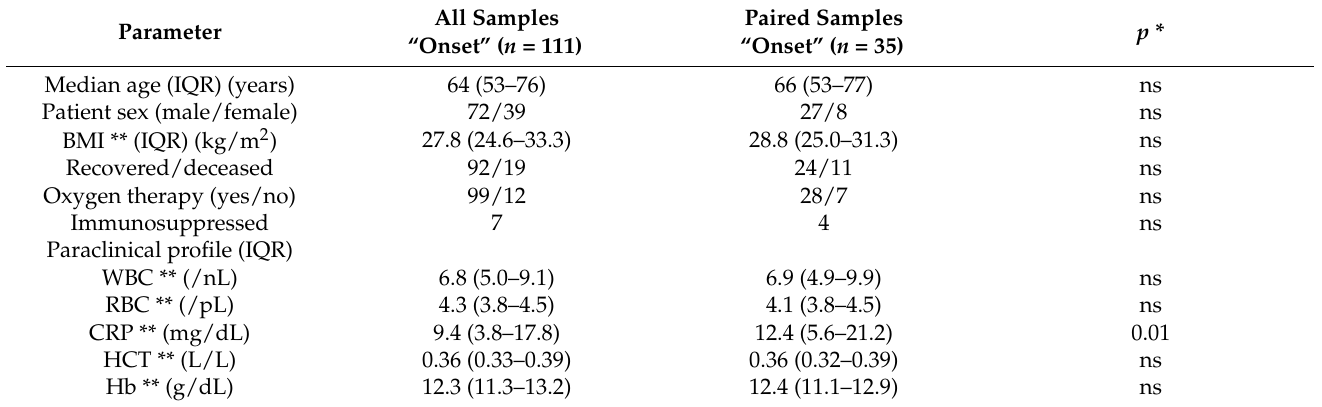
Table 1. Clinical demographic characteristics of all hospitalized patients and the paired sample group at the time of hospitalization (onset). * p -values less than 0.05 are significant; ns: not